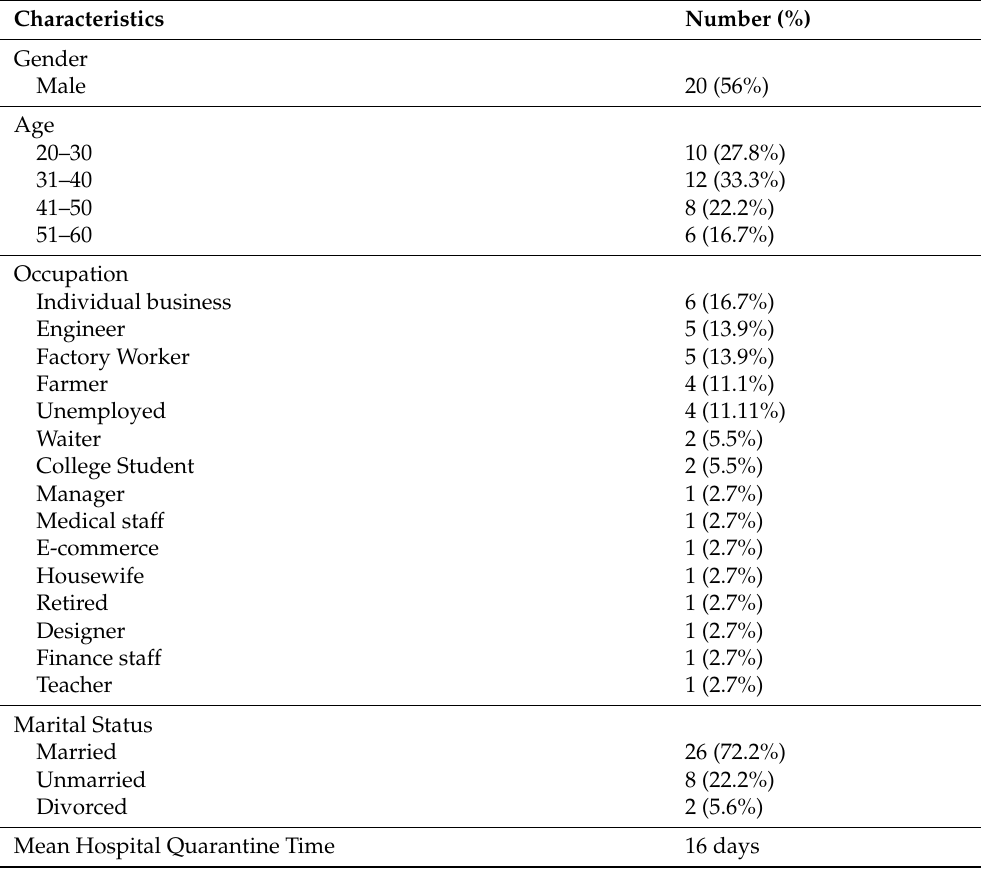
Table 1. Sociodemographic characteristics of COVID-19 patients ( n =